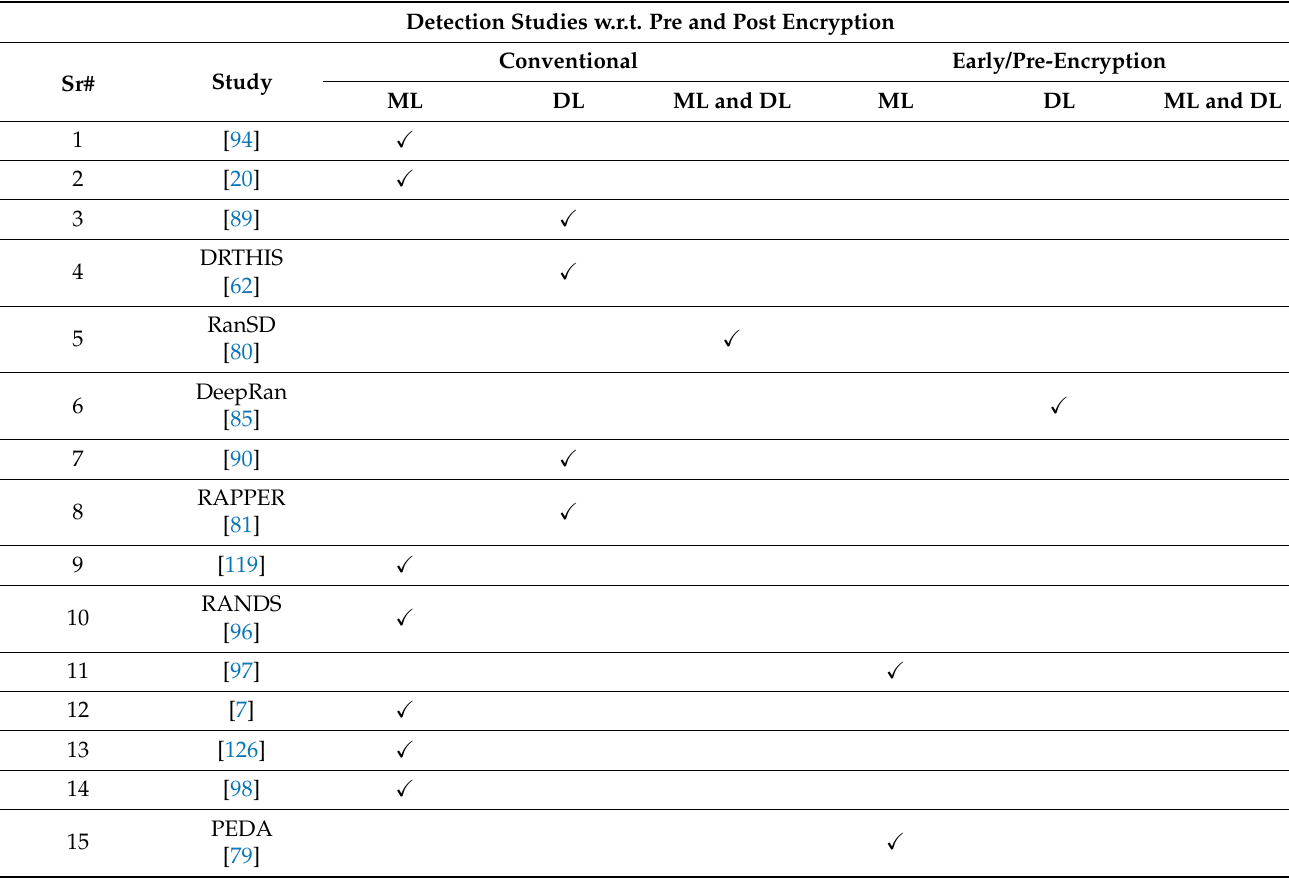
Table 6. Summary of Ransomware studies w.r.t Pre and Post Encryption. Detection Studies w.r.t. Pre and Post